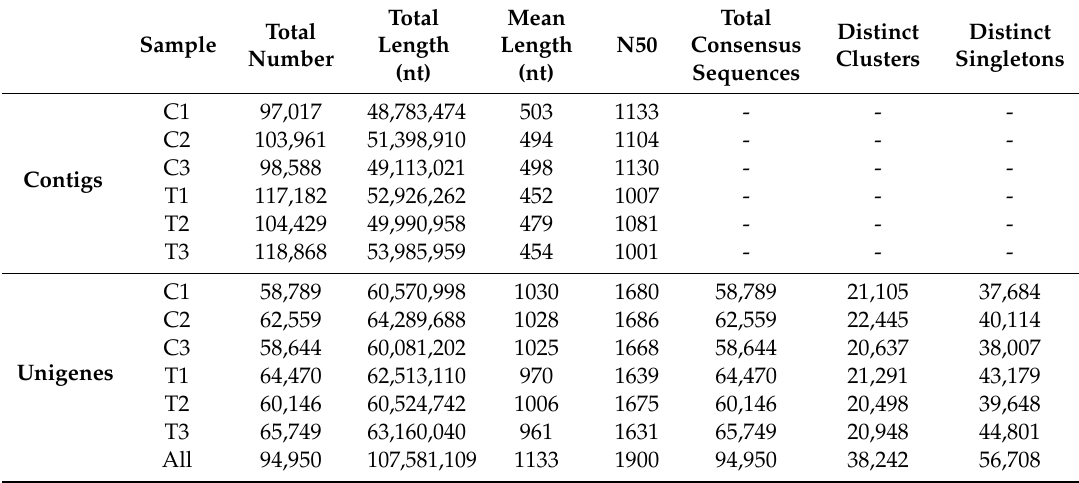
Table 1. Statistic of sequencing and de novo assembling of transcriptome in F. tataricum